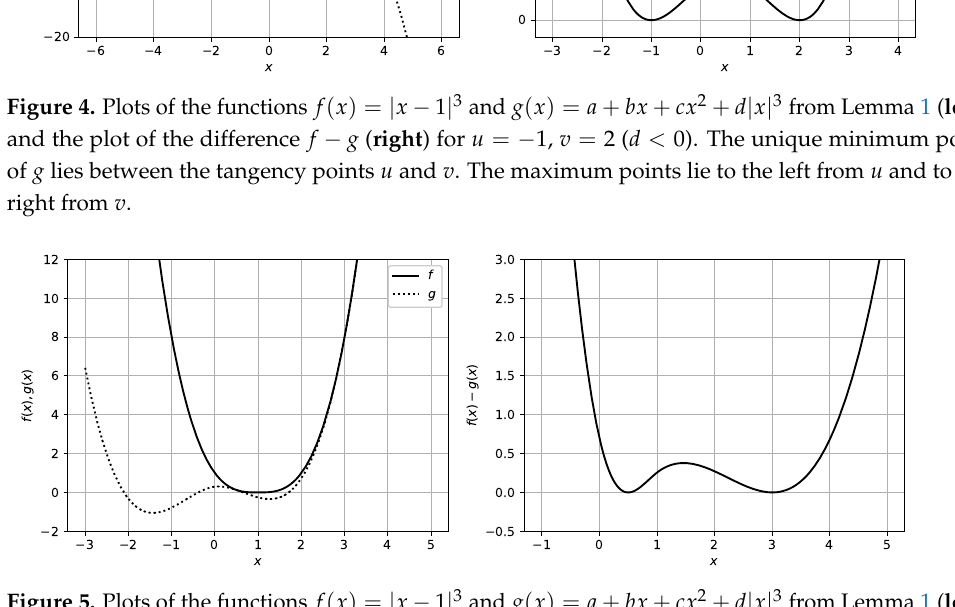
Figure 5. Plots of the functions f ( x ) = | x − 1 | 3 and g ( x ) = a + bx + cx 2 + d | x | 3 from Lemma 1 ( left ), and the plot of the difference f − g ( right ) for u = 0.5, v = 3 ( d > 0). The unique minimum point of g lies between the tangency points u and v . Two more stationary points, the minimum and the maximum points, lie to the left of u